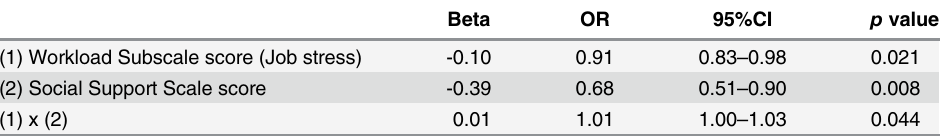
Table 4. Interaction between perceived social support and perceived job stress due to workload onto having “ a very low level of physical activity ” (i.e. having (cid:1) 30 minutes of moderate or vigorous physi- cal activity in the last